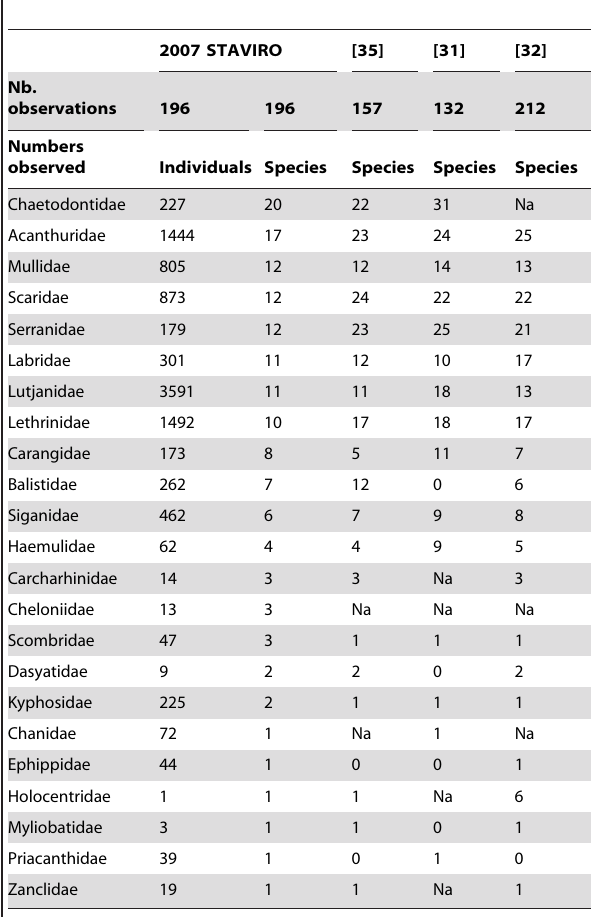
Table 3. Species number, abundance and frequency of the families observed in the 196